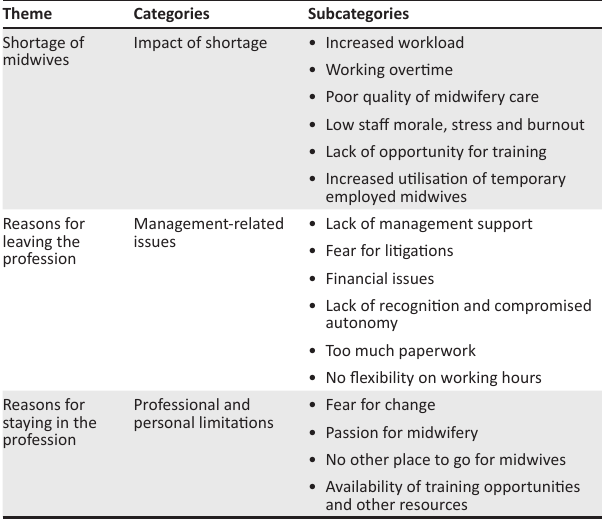
TABLE 1: Categories and themes generated from